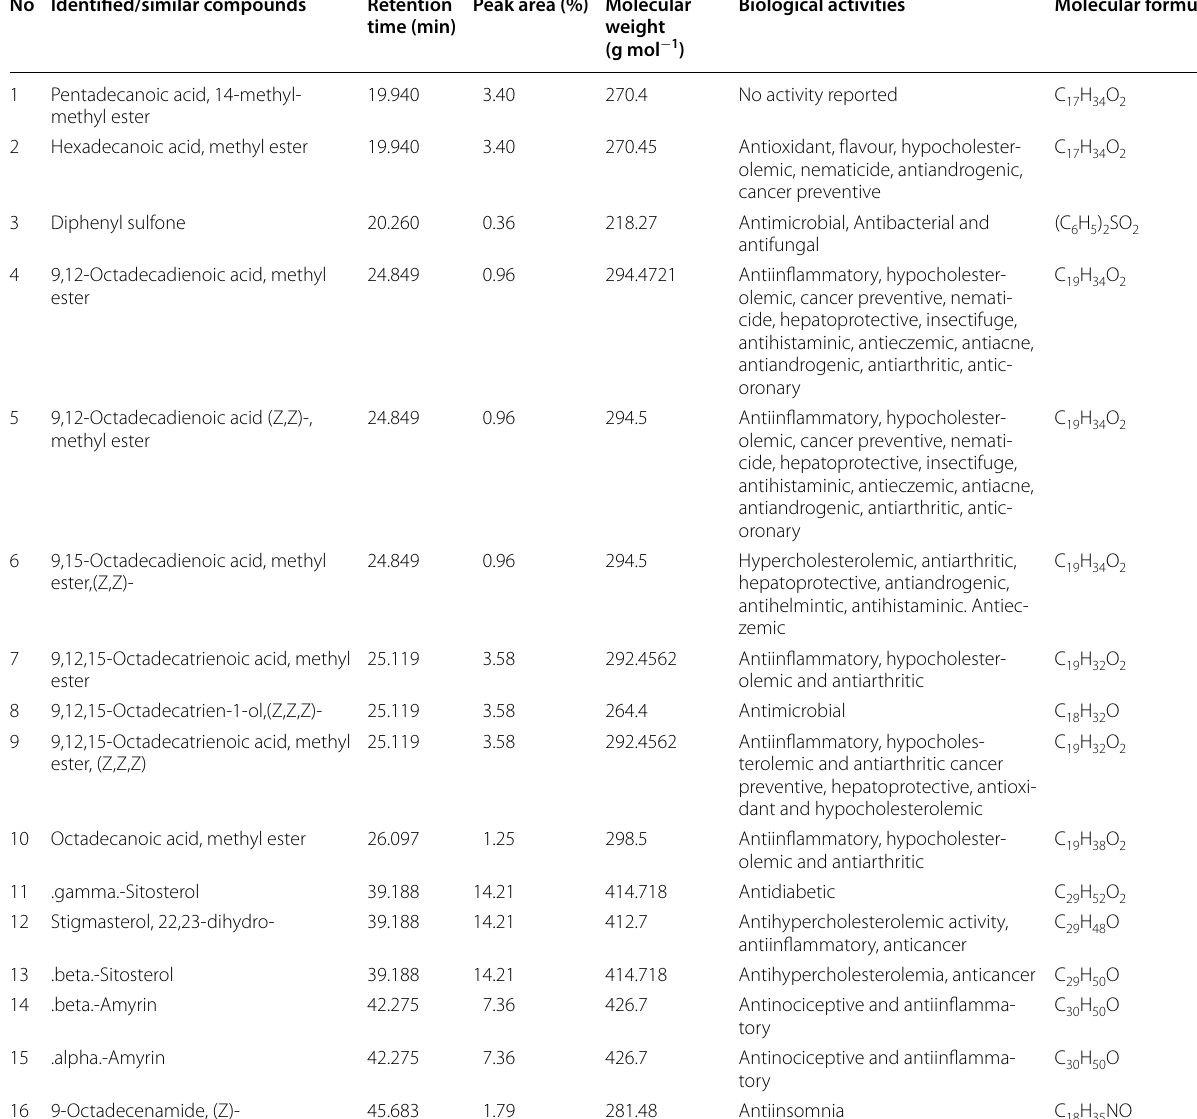
Table 1 Phytochemical constituents compounds identified and biological activities of dichloromethane Clinacanthus nutans leaf extracts by gas chromatography–mass spectrometry (GC–MS) No Identified/similar